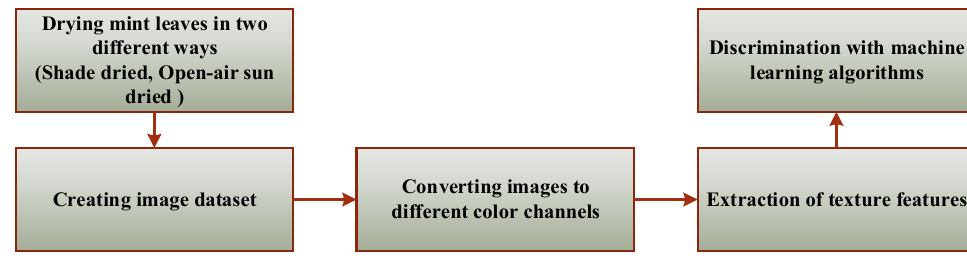
Figure 5. Algorithm steps applied to experimental study.